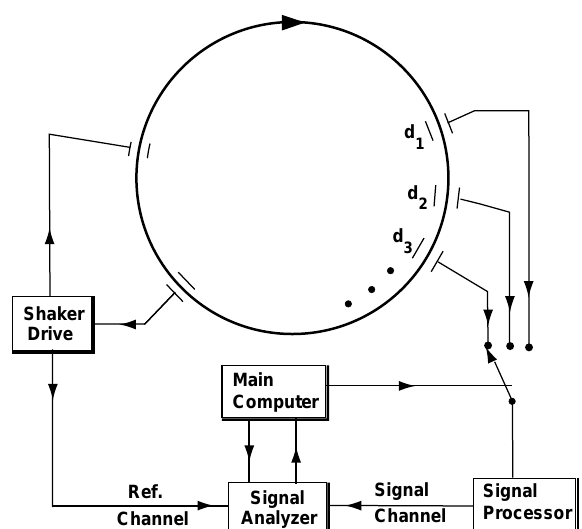
FIG. 1. Schematic illustration of the experimental setup. The beam position detectors are labeled d 1 , d 2 , d 3 ,